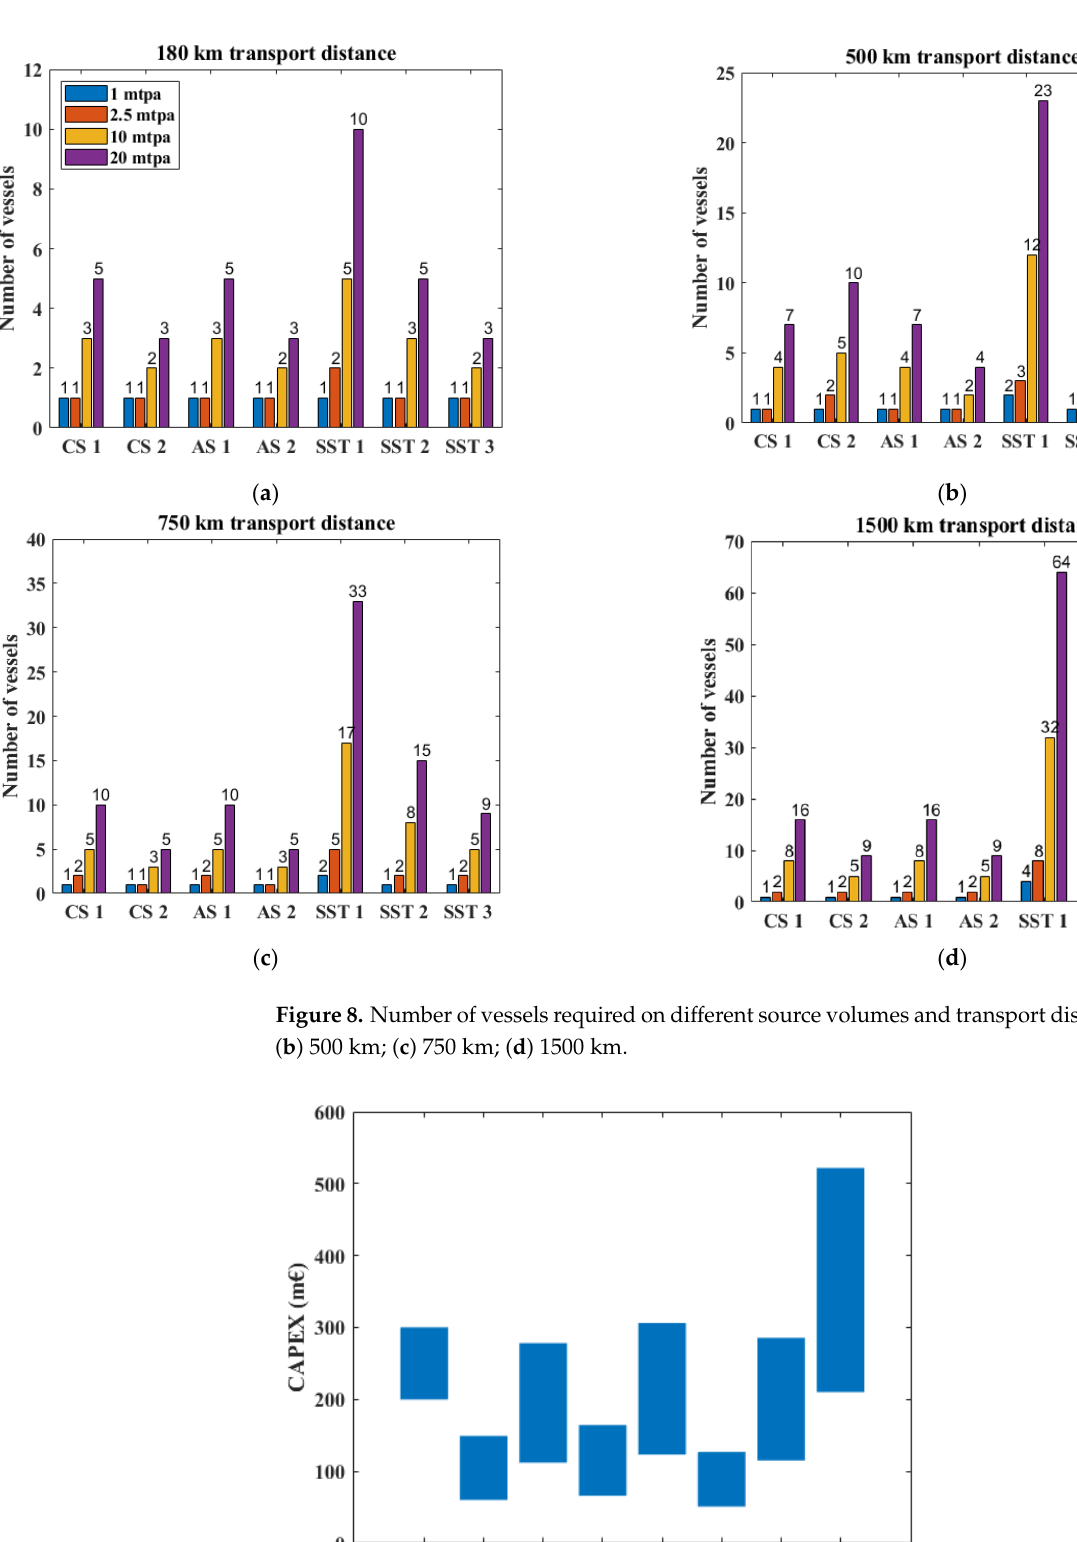
( d ) Figure 10. CAPEX and OPEX ratio on different source volumes and transport distances: ( a ) 180 km; ( b ) 500 km; ( c ) 750 km; ( d ) 1500 km. 4.2.5. Crewed vs. Autonomous Tanker Ship The crewed tanker ship is found to be slightly cheaper (up to 8%) compared to the autonomous tanker ship. This contrasts with the results presented in MUNIN D9.3 report [22], where the autonomous version of a specific bulker ship is up to 8.6% cheaper than its crewed counterpart. The first reason is due to the low CAPEX for the bulker ship used in MUNIN D9.3 report [22]. The MUNIN ship’s CAPEX is 34 m€. The tanker ships con- sidered in this paper are CO 2 carriers that carry expensive equipment and have a CAPEX